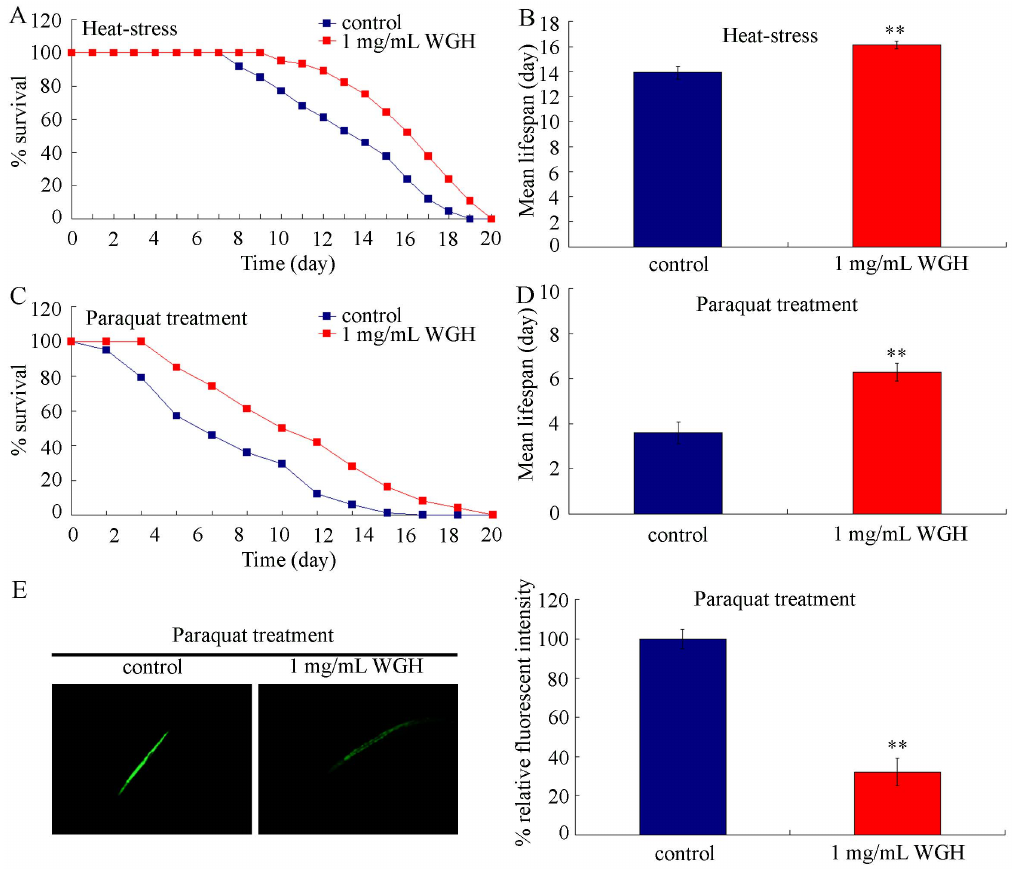
Figure 4. Heat-stress and oxidative stress resistance of WGH treated C.elegans . (A) Lifespans of heat-stress exposed nematodes pretreated with or without 1 mg/mL of WGH. (B) Mean lifespans of heat-stress exposed nematodes pretreated with or without 1 mg/mL of WGH. (C) Lifespans of paraquat exposed nematodes pretreated with or without 1 mg/mL of WGH. (D) Mean lifespans of paraquat exposed nematodes pretreated with or without 1 mg/mL of WGH. (E) Intestinal ROS production in paraquat exposed nematodes pretreated with or without 1 mg/mL of WGH. Nematodes pre-treated with 1 mg/mL of WGH for 48-hr were transferred to the 35 u C condition for 16–hr or 2 mmol/L of paraquat for 6–hr. WGH, wheat gluten hydrolysate. Bars represent means 6 S.E.M. ** p , 0.01.